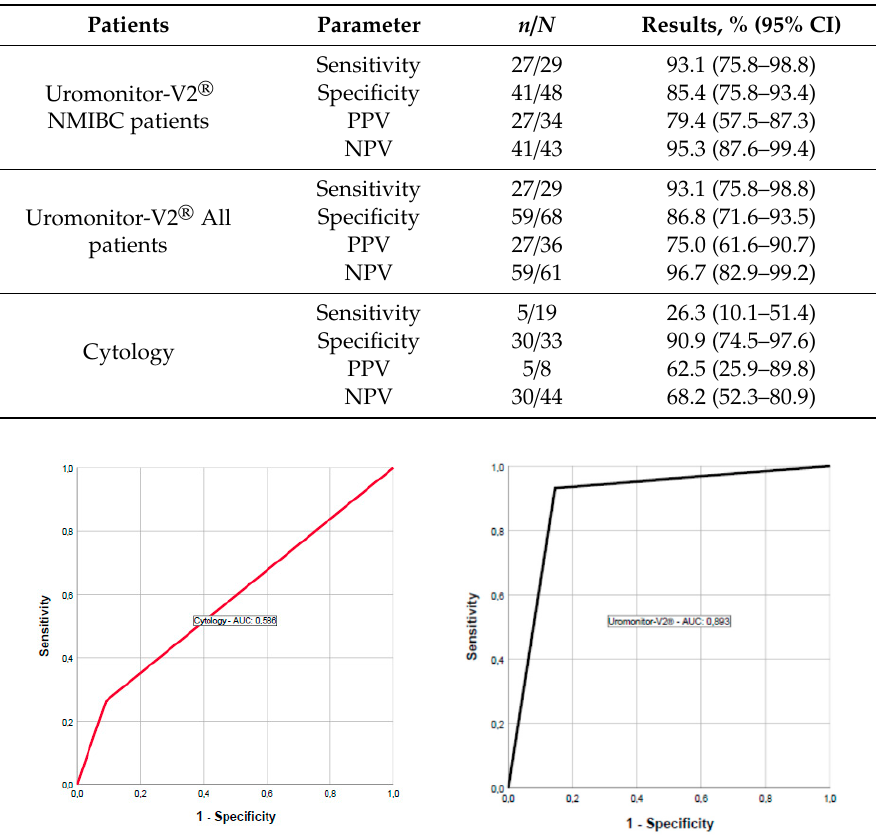
Figure 1. Comparing ROC curves of urine cytology (red) with Uromonitor-V2® (black) for patients with a history of NMIBC.